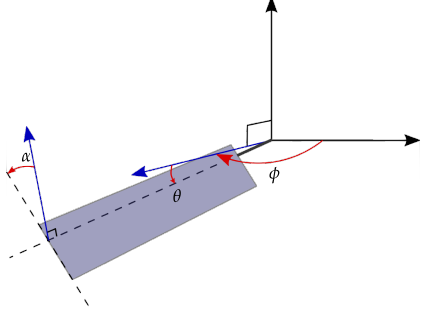
Figure 1. Schematic of the three rotational axis and angles describing the flapping wing kinematics: stroke φ , elevation θ and pitching α